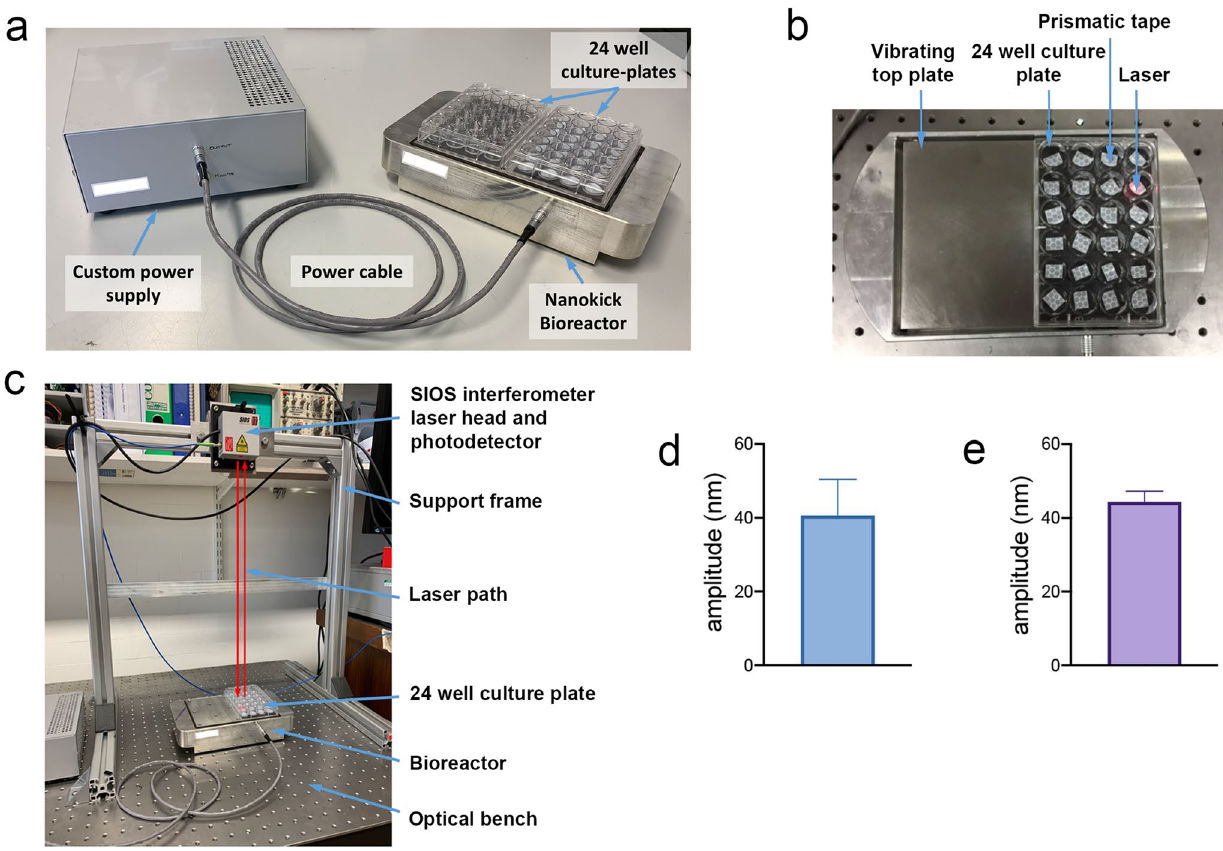
Figure 1. Nanovibrational stimulation setup and measurement. ( a ) Nanovibrational bioreactor and power supply. ( b ) 24 well cell culture plate attached to the bioreactor using a magnetic sheet. Reflective prismatic tape is placed in the wells (or on top of gels) so that the interferometer laser is reflected back to the detector. ( c ) Interferometer measuring bioreactor vibrations in the 24 well plate. ( d ) 2D nanovibrations in two 24 well plates. No cells were present during measurement. Measurements were taken in triplicate from each well, giving an average displacement of 40.6 nm at 1000 Hz frequency. ( e ) 3D (collagen gel) nanovibrations in a 24 well plate giving an average displacement of 44.4 nm at 1000 Hz